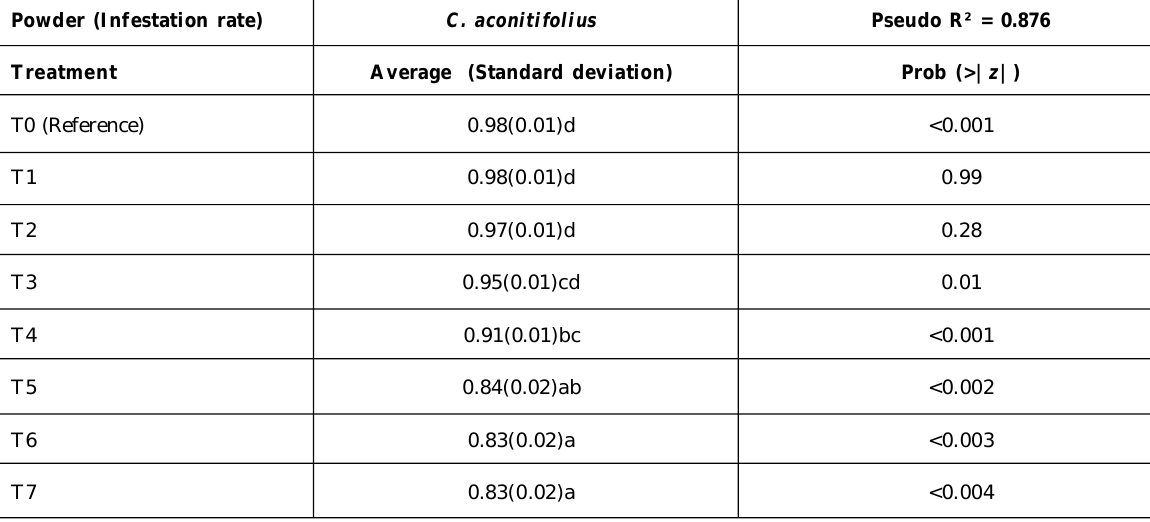
Table 3 : Result of beta regression applied to infestation rate of C. maculatus under the effect of powder of